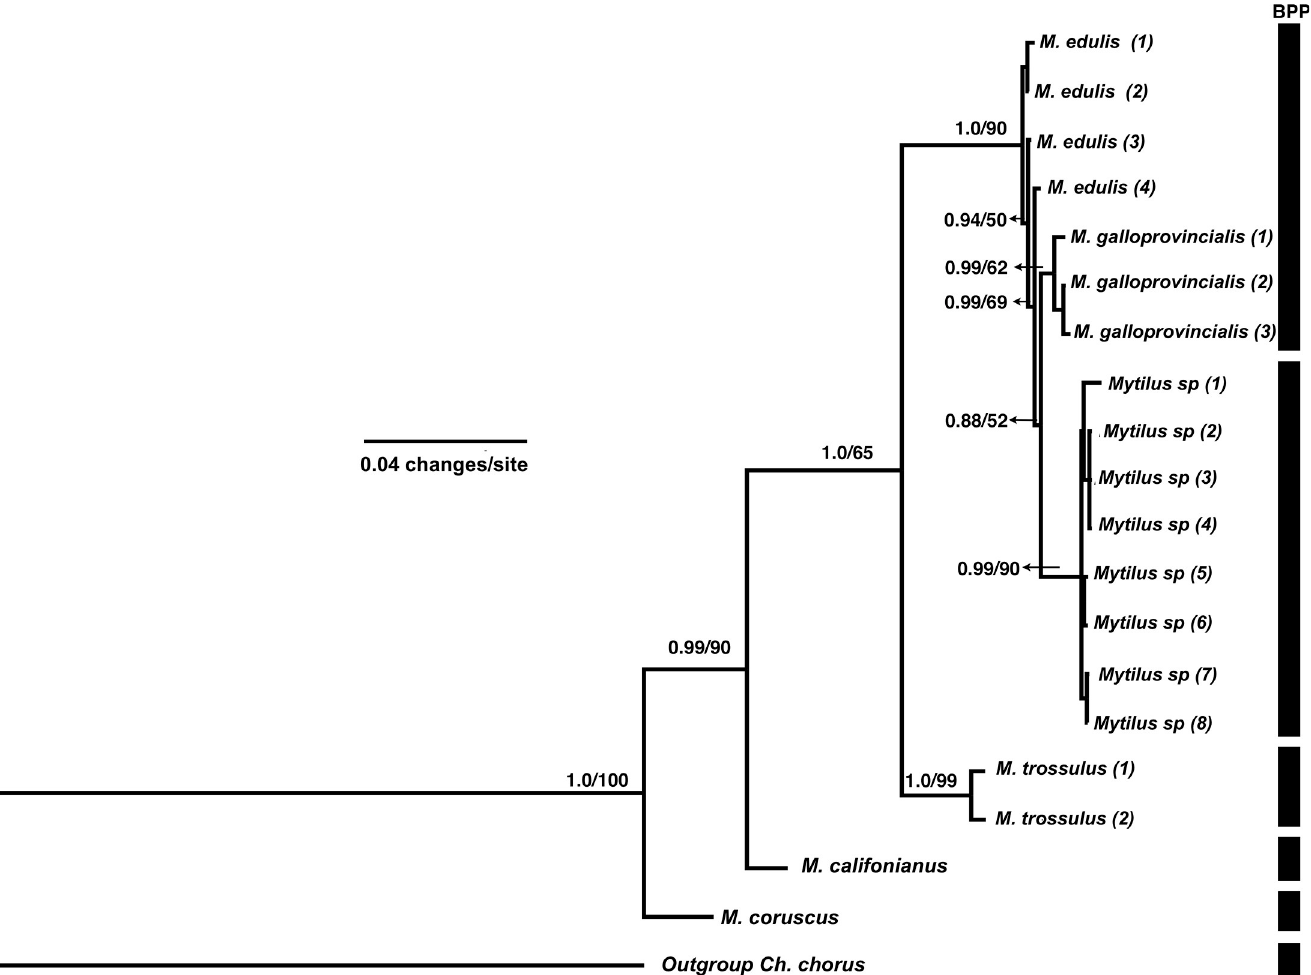
Fig 3. Bayesian tree using the concatenated matrix data set (COI+16S+18S). The numbers above branches represent the posterior probability/bootstrap support values. Bar on the right of the tree indicate the species limits as proposed by BPP (multilocus analysis). M . edulis = (1) Canada, (2) Sweden, (3) Cornwall, UK, (4) Punta Cueva, Argentina; M . galloprovincialis = (1) Moa ñ a-Pontevedra, Spain, (2) Lota, Chile, (3) South Africa; Mytilus sp. clade = (1) Auckland Islands, New Zealand, (2–3) Quillaipe, Chile, (4) Maullin, Chile, (5) Punta del Este, Uruguay, (6) Maullı´n, Chile, (7–8) Puerto Cisne, Chile; M . trossulus clade = (1) Penn Cove, USA, (2) Bras d’Or lake, Canada. Sequence details are provided in Table